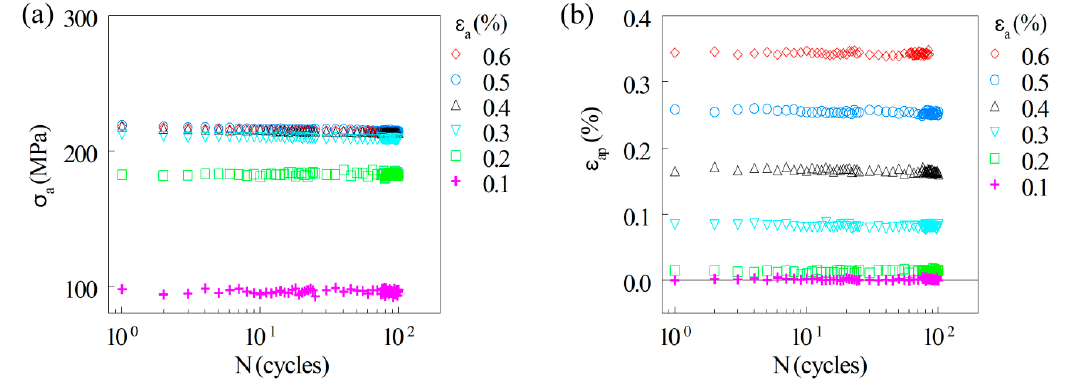
Figure 5. ( a ) Stress amplitude vs. the number of applied cycles in loading with increasing total strain amplitudes at 800 °C. ( b ) Dependence of evaluated plastic strain amplitude on the number of cycles. Saturated hysteresis loops at the end of each block of strain amplitude were recorded and